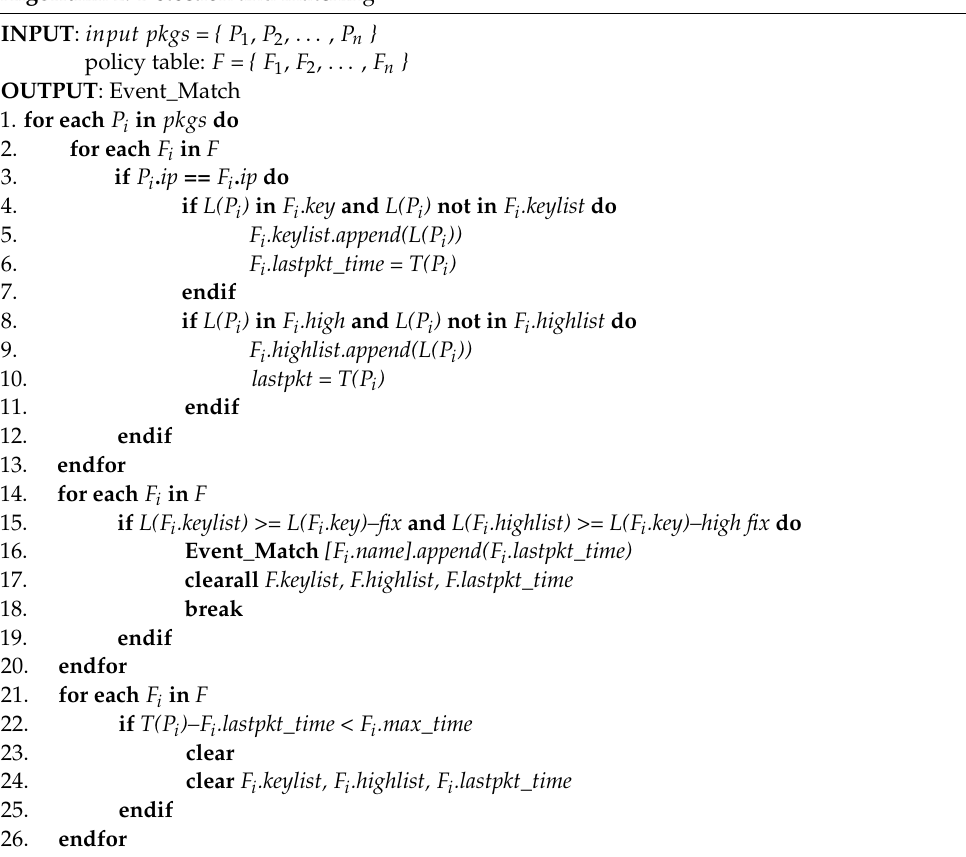
Algorithm 2. Detection and